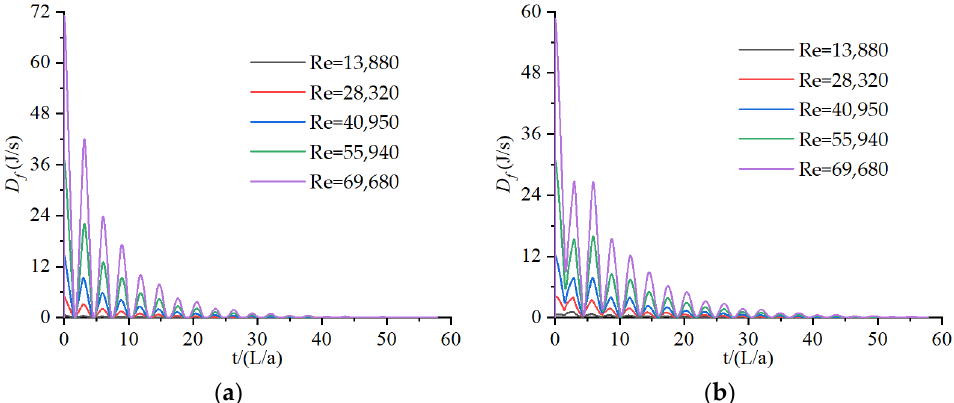
Figure 7. Frictional work D f at different Re values in the critical region: ( a ) 1D model; ( b ) 2D model.